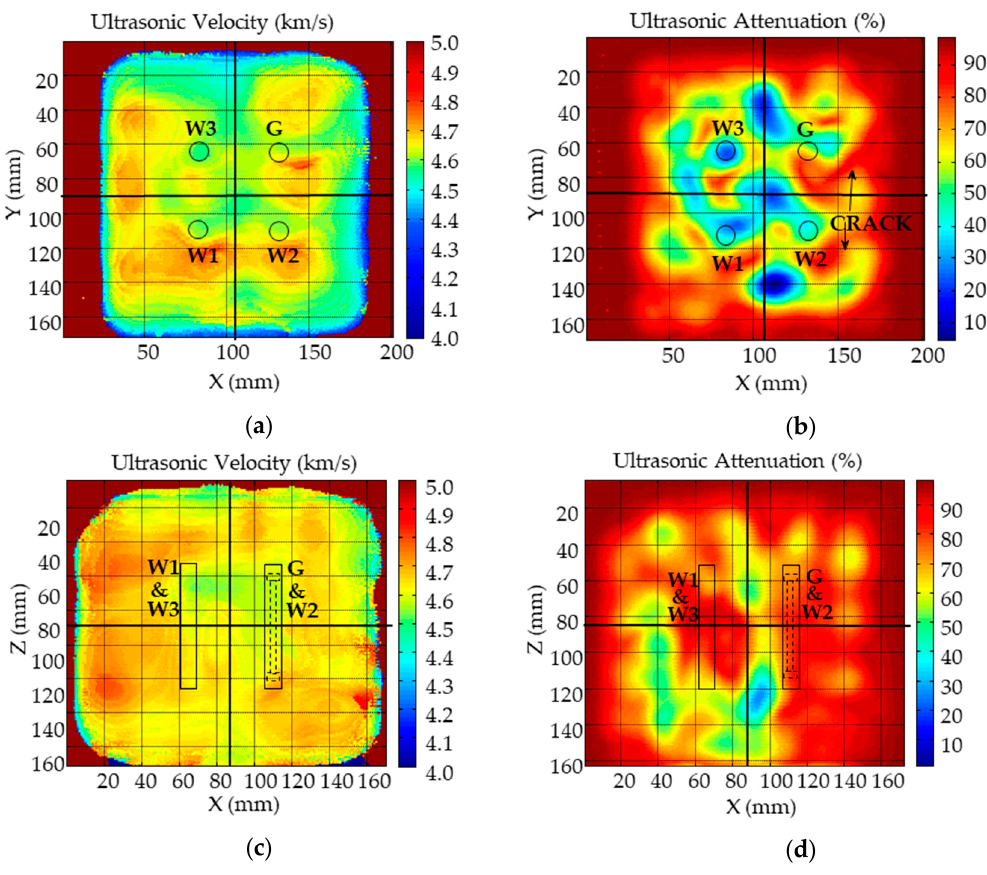
Figure 6. Ultrasonic images of the cubic specimen obtained after the stress cycles, ( a ) Azimuthal velocity, ( b ) Azimuthal attenuation, ( c ) Lateral velocity, ( d ) Lateral attenuation.